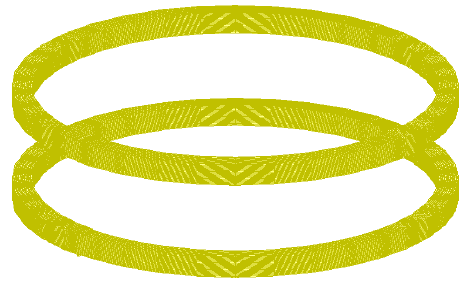
Figure 8. The structure of the simulation coils.